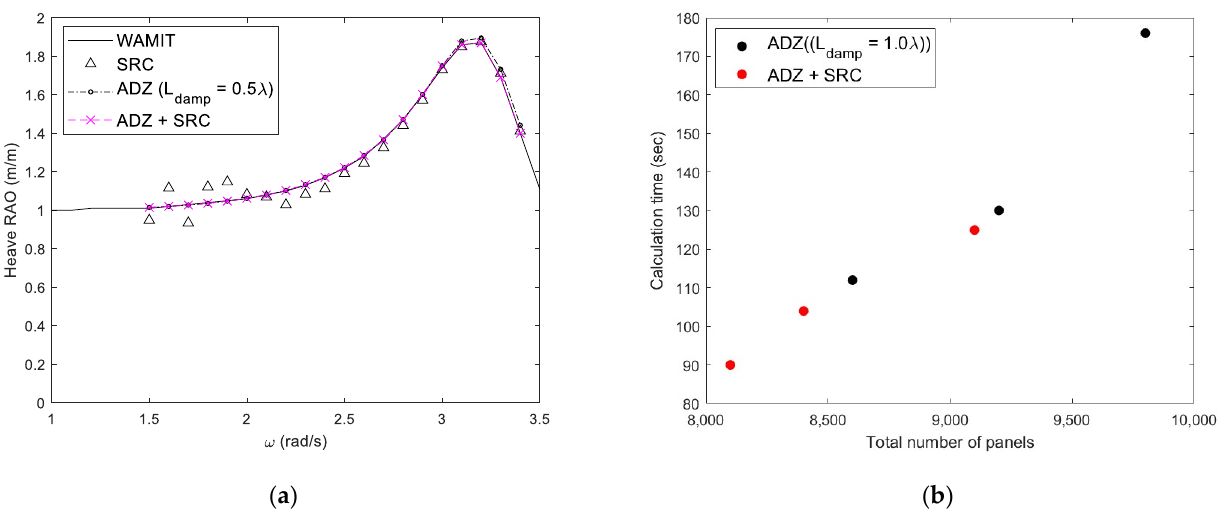
Figure 13. Numerical results for various radiation conditions: ( a ) heave RAOs for different radiation conditions; ( b ) calculation time according to the total number of panels.